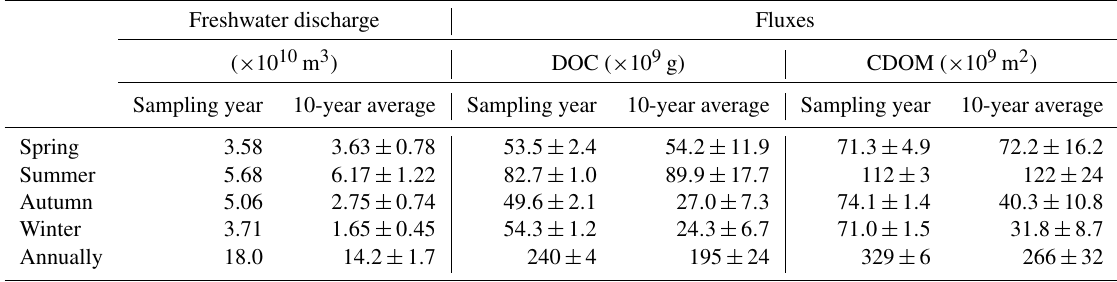
Table 1. Estimates for DOC and CDOM ( a 330 -based) export from the Pearl River to the South China Sea based on monthly freshwater discharge rates for the sampling year and those averaged over a 10-year period from 2006 to 2016. Standard errors of the fluxes for the sampling year were derived from the standard errors of the effective [DOC] and a 330 (Table S3), while those for the 10-year period also include the interannual variability of the freshwater discharge rate.